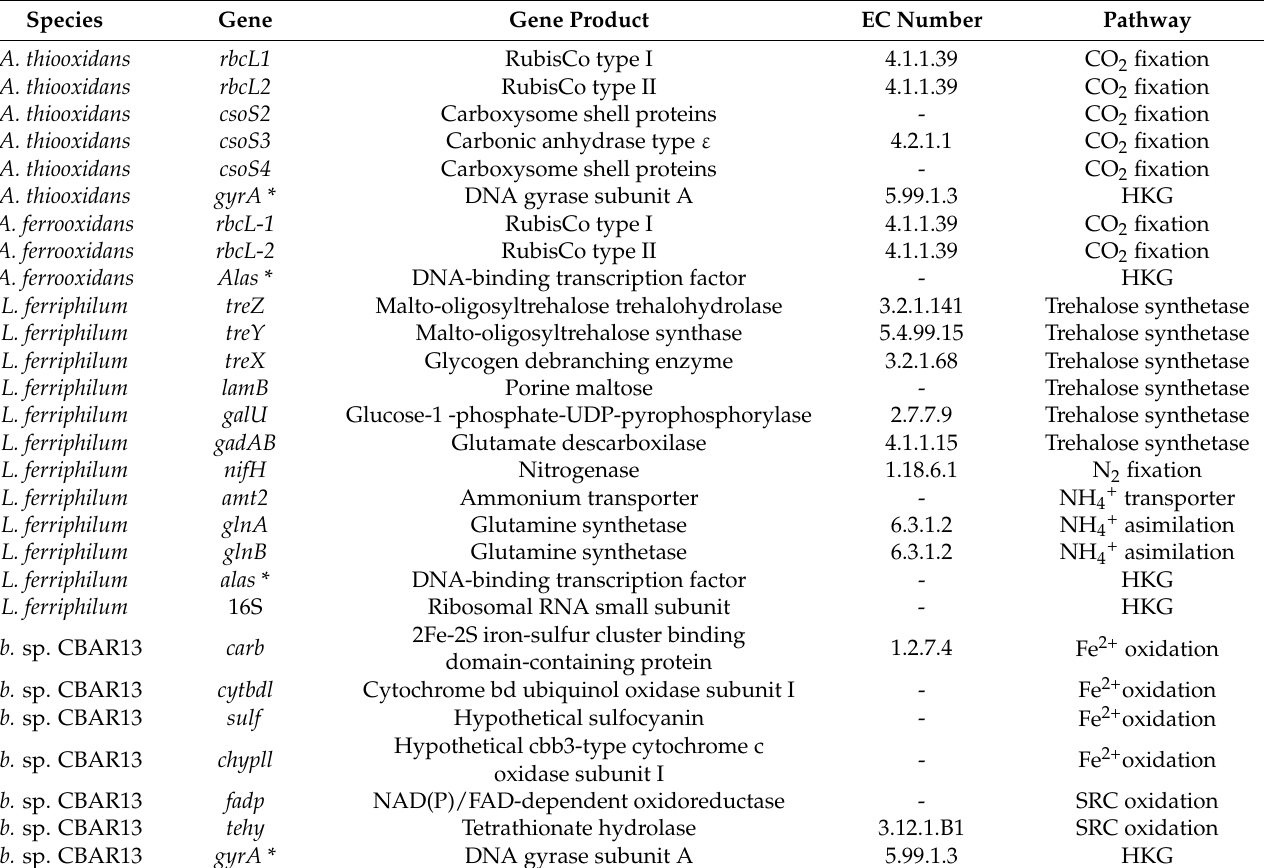
Table 3. Candidate genes analyzed for biomarkers identification and industrial validation. The CO 2 fixation genes are from the Calvin–Benson–Basham cycle. HKG is housekeeping genes. SRC is sulfur-reduced compounds. Sb. sp. is Sulfobacillus sp. Genes that were used as endogenous control are indicated with